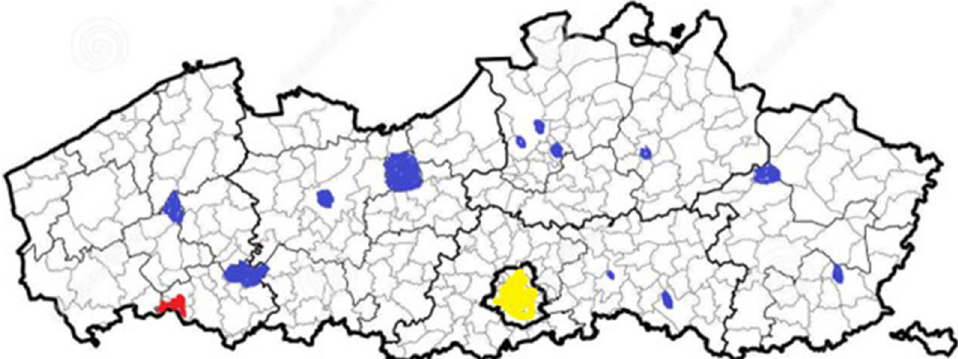
Fig. 1 Map of Flanders showing the administrative borders of municipalities. Between the most western and most eastern point: about 230 km. In red the industrial “Grensland” area (without known PFAS contamination) where the 197 adolescents participating in FLEHS-2 resided. In blue the area’s where the 205 adults participating in the FLEHS 3 campaign resided, as a random sample of the Flemish population. In yellow the agglomeration of Brussels which is not part of Flanders and is not involved in this